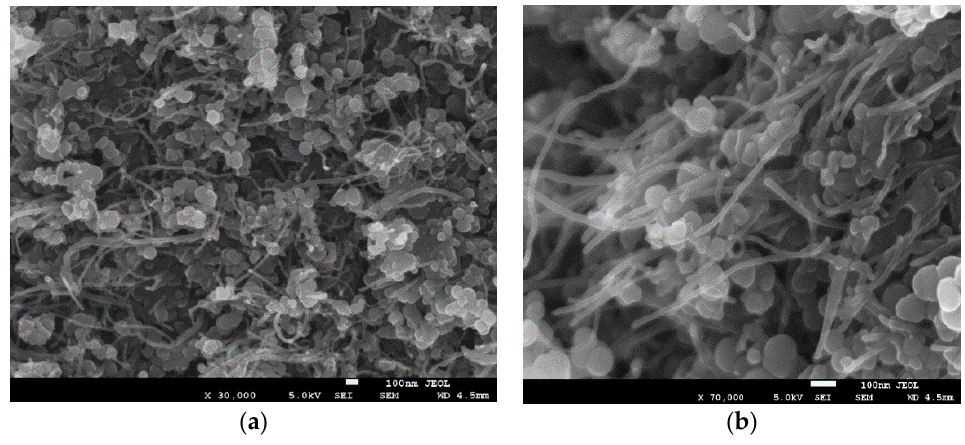
Figure 2. The characterization of the CNTs ‐ Boron unprocessed sample before sintering. ( a ) Low magnification (30,000×); ( b ) High magnification (70,000×).